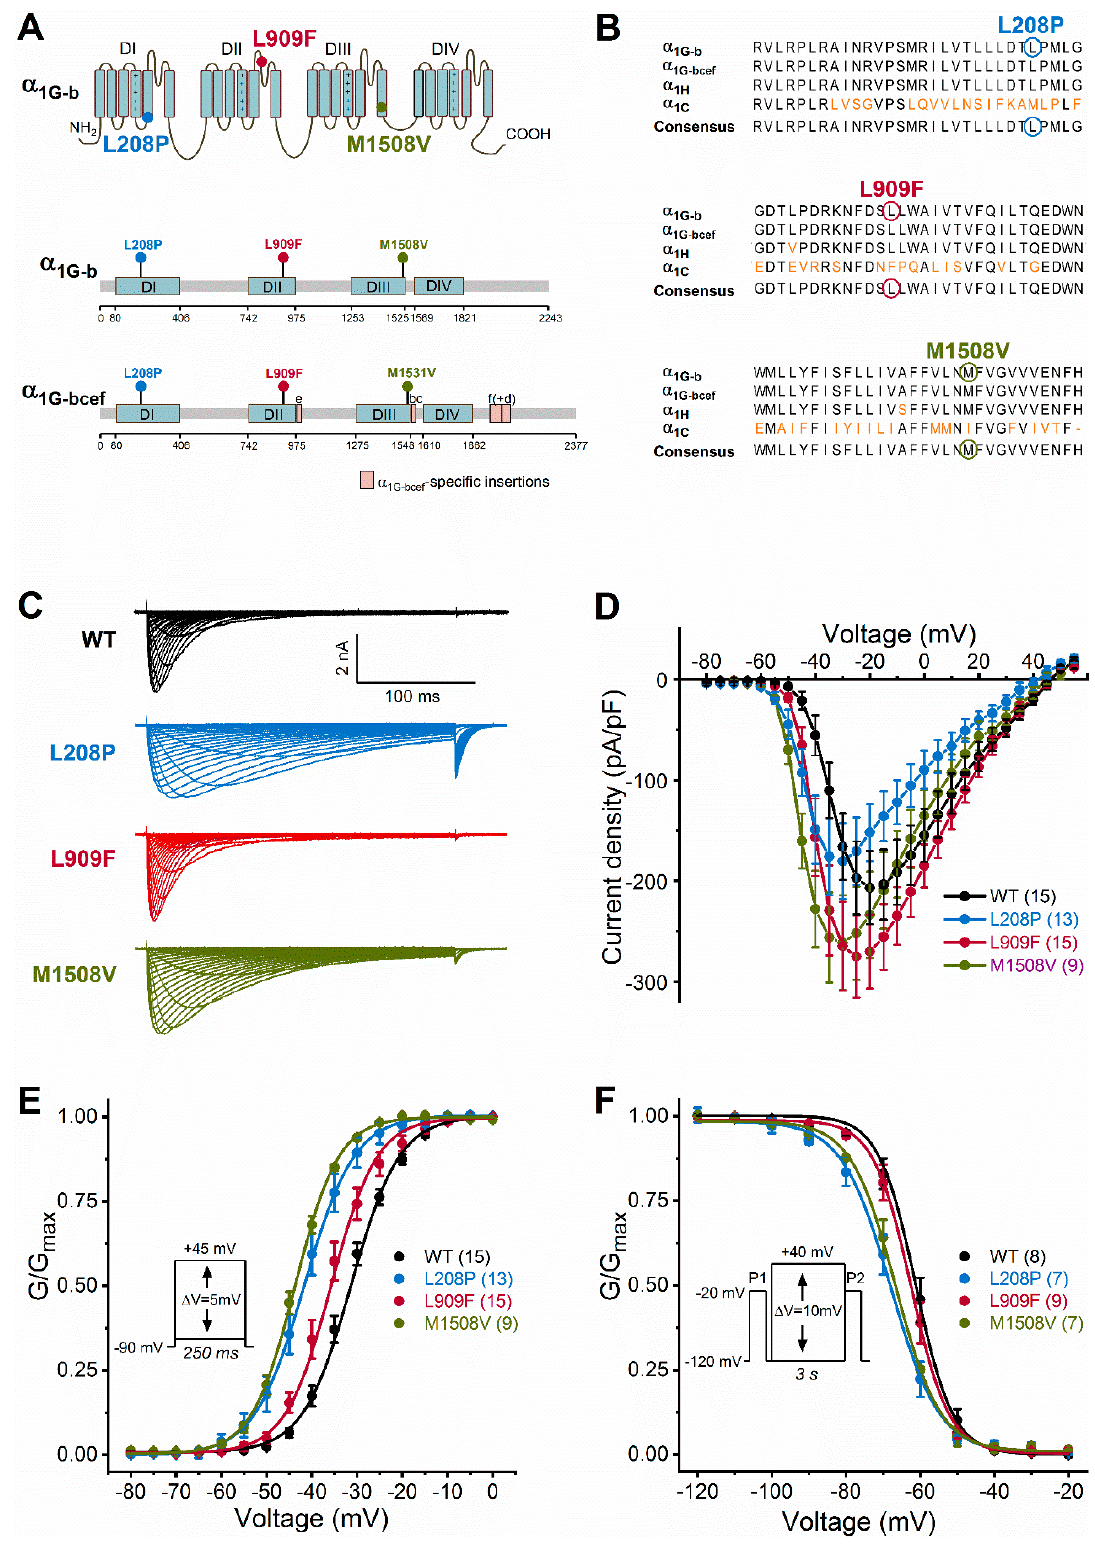
Figure 1. Ca v 3.1 channel transmembrane topology, calcium channel homology, and voltage dependence of activation and inactivation of wild-type and mutant Ca v 3.1 channels. ( A ), Location of Ca v 3.1 channel mutations. The four membrane domains are labelled DI − DIV. The positive charges of segment 4 are shown in each domain. Note that all mutations fall in the pore region (segments 5 or 6). Lollipops representations of isoform b ( α 1G-b ) and isoform bcef ( α 1G-bcef ), showing the position of mutations. The M1508V mutation in α 1G-b corresponds to the M1531V mutation in α 1G-bcef [6]. Note the